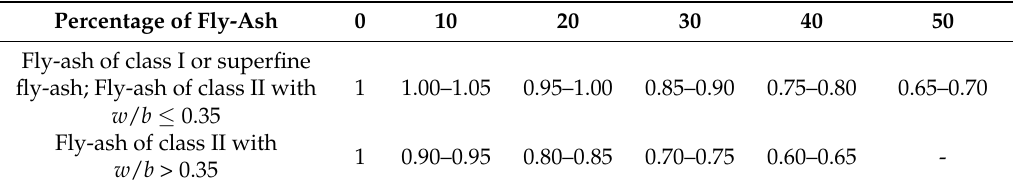
Table 2. Proposed values for mortars with different fly-ash and w/b [65].